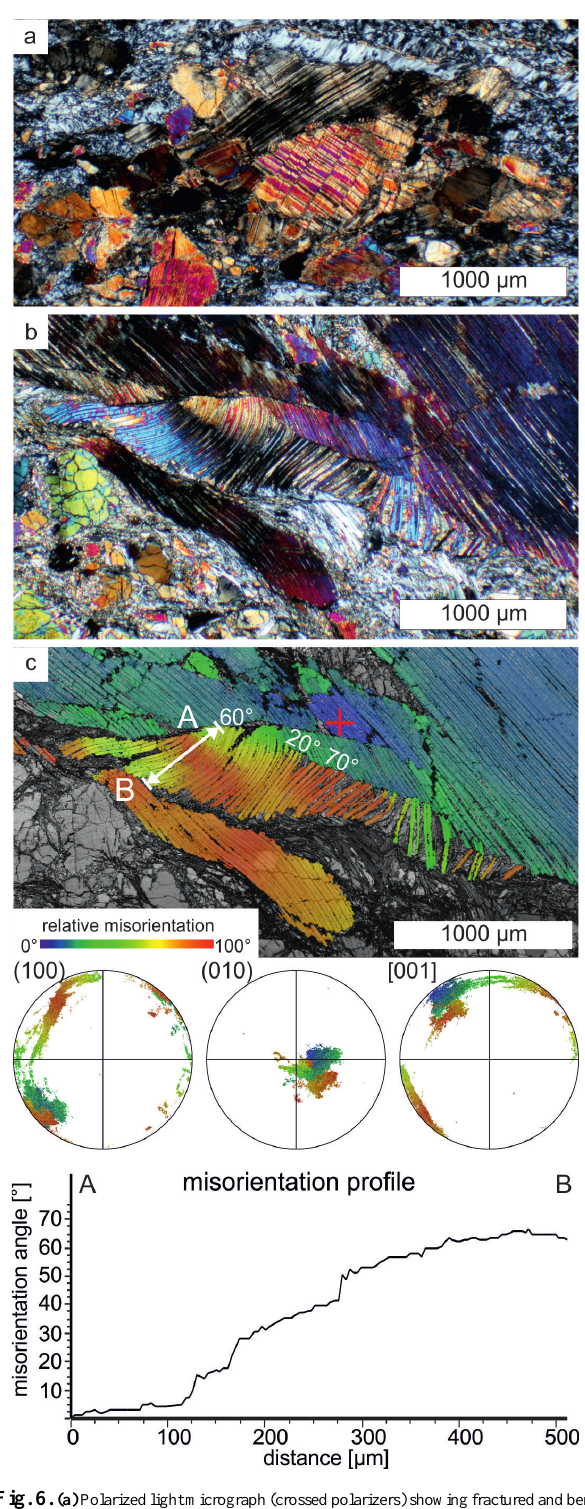
Fig. 6. (a) Polarizedlightmicrograph(crossedpolarizers)showingfracturedandbent diopside porphyroclast with exsolution lamellae parallel (100) (sample CT_07-21); (b) polarized light micrograph (crossed polarizers) showing kinked and bent diopside porphyroclast with exsolution lamellae parallel (100) (sample CT_07-13); (c) EBSD map (relative misorientation to a reference point indicated by red cross) of kinked and bent diopside porphyroclast of the area shown in b. White labelled angles give relative misorientation over kinked domains. Corresponding pole figures show dispersed (100) planes and [001] directions. The [010] axis represents the common rotation axis. White line indicates location of misorientation profile shown in (d) . (d) Misorienation profile relative to the first point (a) ; line is indicated in the EBSD map in (c)